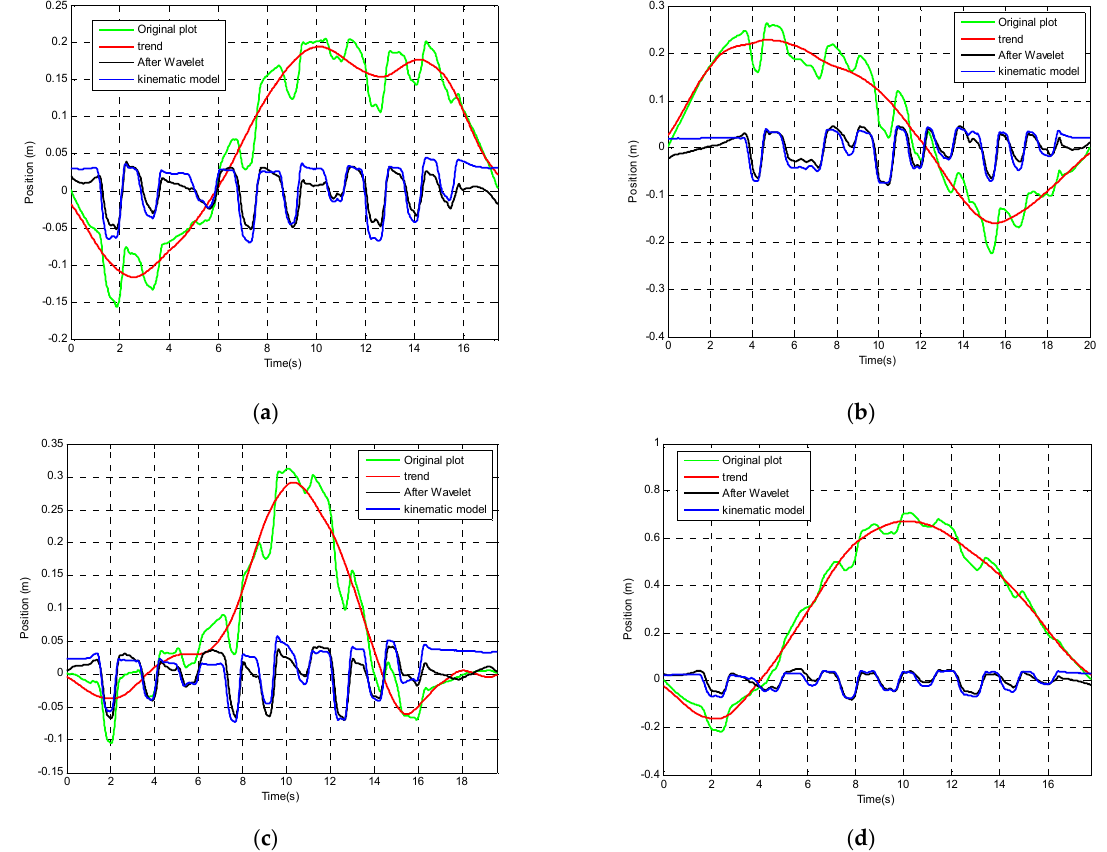
Figure 13. Drift correction for position using wavelet analysis. ( a ) Experiment Test 1. ( b ) Experiment Test 2. ( c ) Experiment Test 3. ( d ) Experiment Test 4.The result after applying the correction using wavelet analysis has been compared with the kinematic modelling tracking result which has been treated as a more accurate position tracking method (See Figure 14).